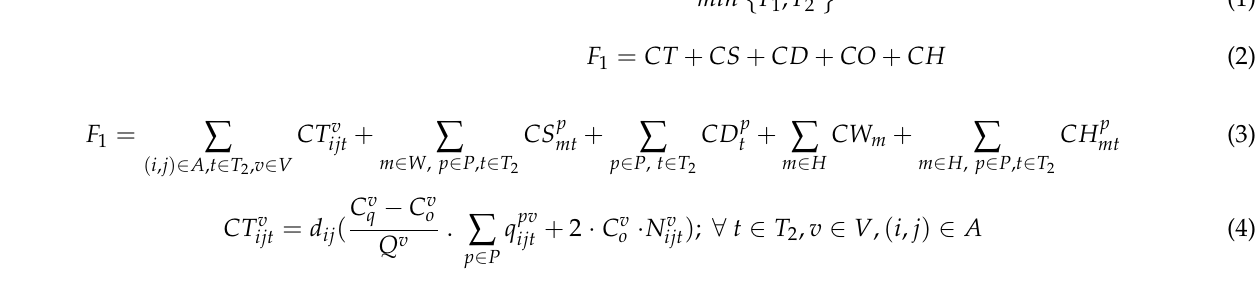
Table 2. The used parameters as well as the binary and continuous variables.